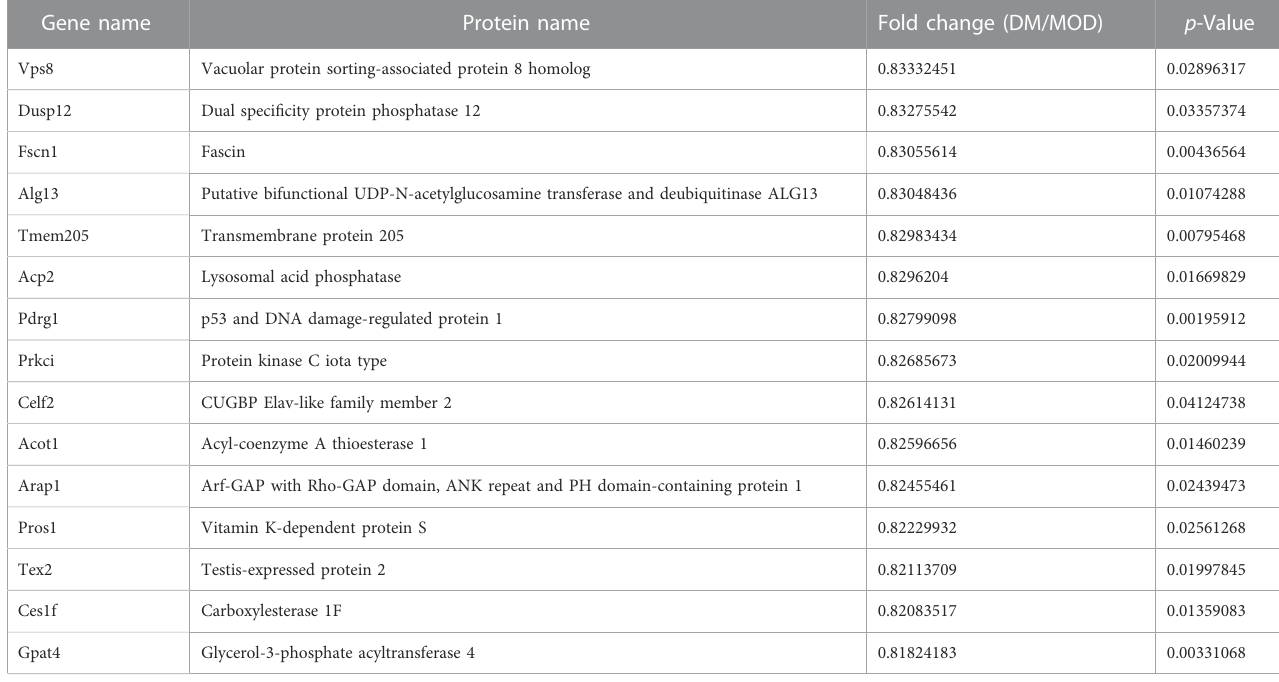
TABLE 2 Selected signi fi cantly downregulated proteins in the Dendrobium mixture (DM) group compared with the model (MOD)